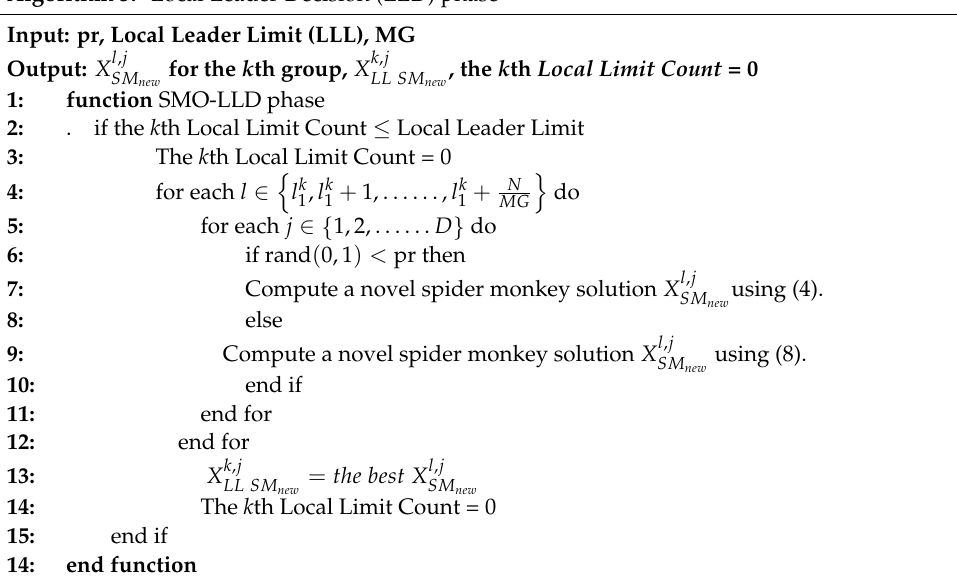
Algorithm 3: Local Leader Decision (LLD)